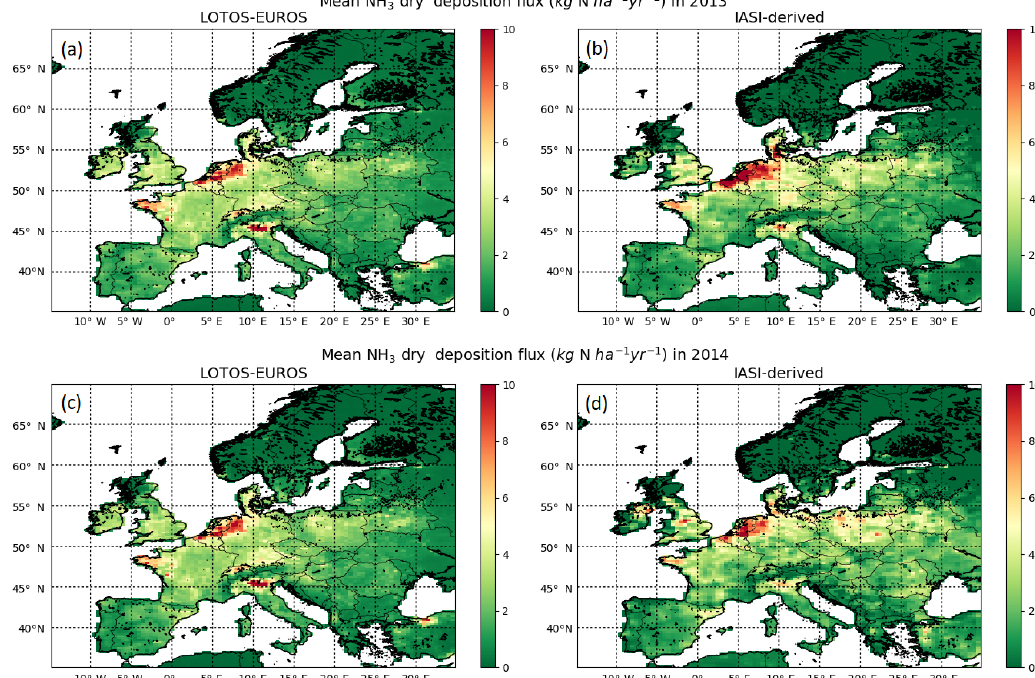
Figure 12. The warm season (April to September) mean NH 3 dry deposition modelled in LOTOS-EUROS (a, c) and inferred from IASI (b,